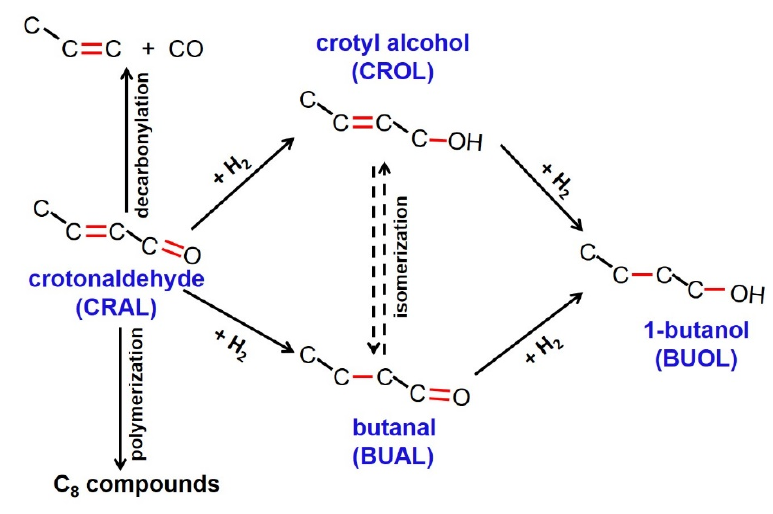
Scheme 1. The hydrogenation reaction routes of crotonaldehyde